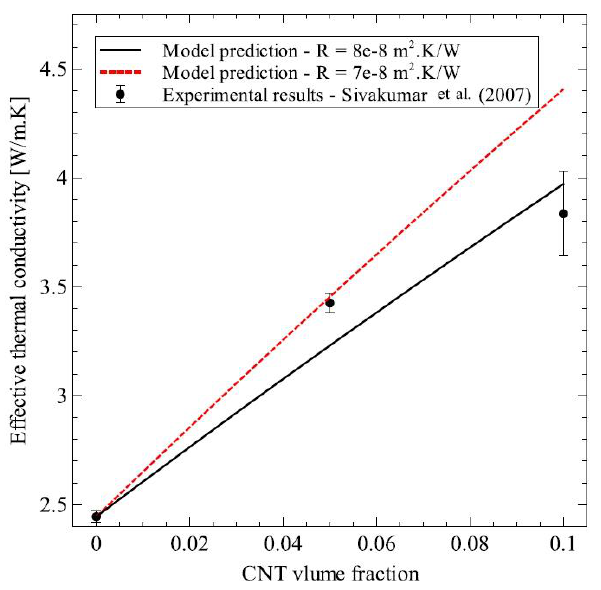
Figure 11. Comparison of model predictions with experimental results for SiO 2 –CNT composite [34].